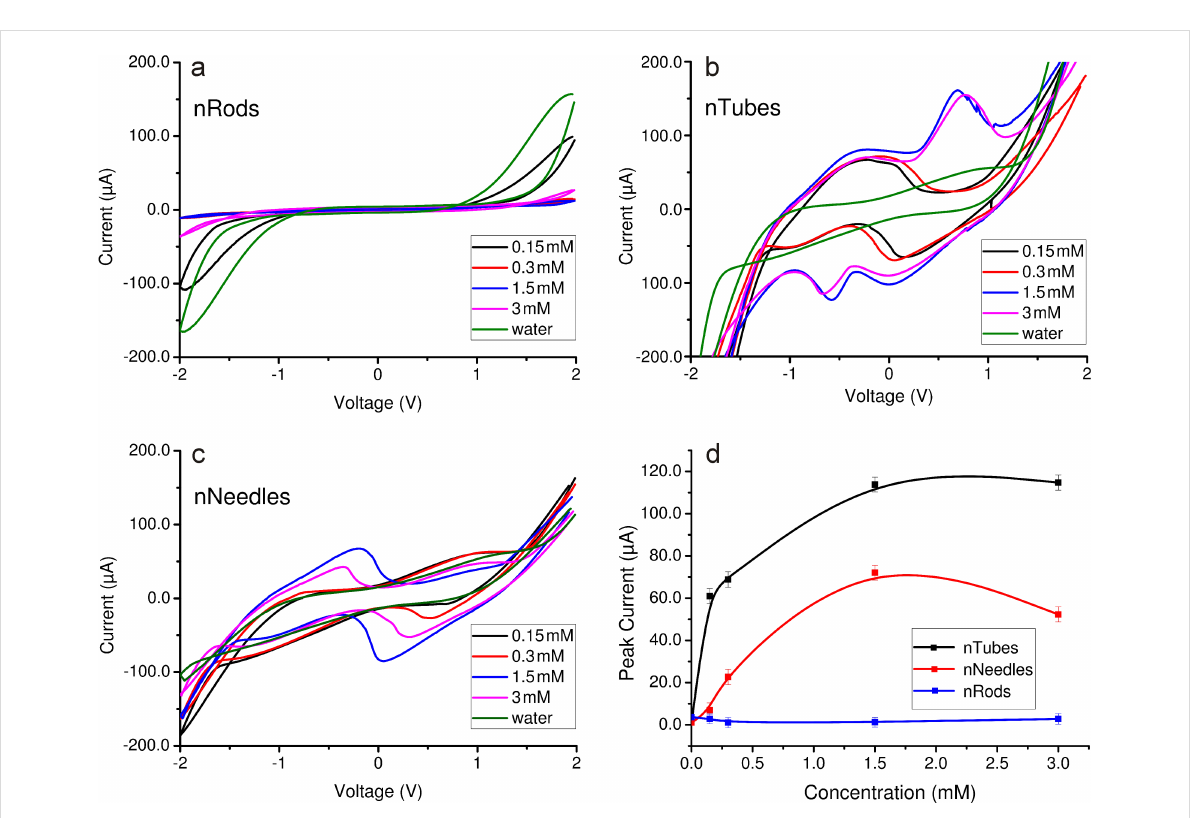
Figure 4: CV curves of aqueous Pb(NO 3 ) 2 solution on ZnO electrodes with different morphologies: (a) nanorods, (b) nanotubes, (c) nanoneedles, and (d) CV reduction peak dependence on Pb(NO 3 ) 2 concentration for all morphologies.